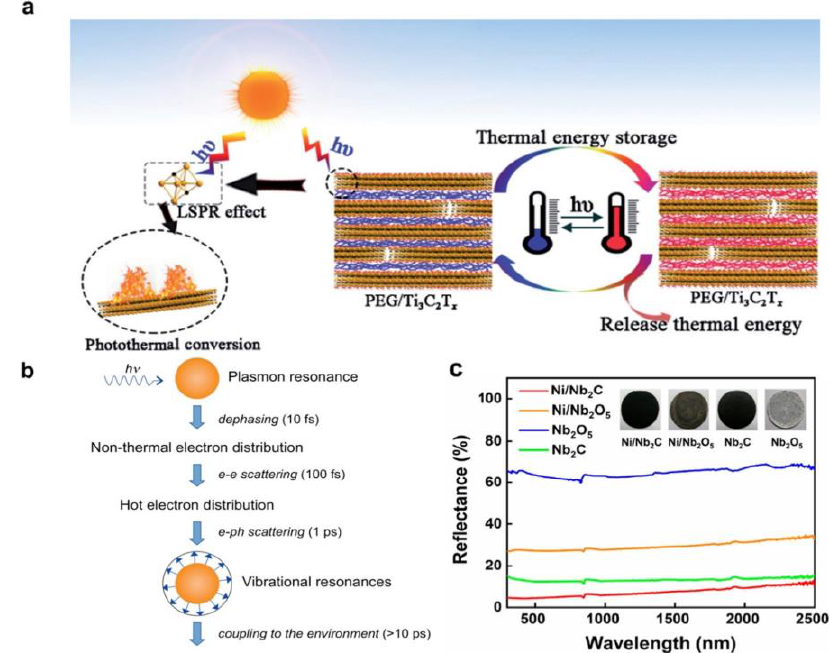
Figure 3. Absorption and photothermal conversion properties of MXenes. ( a ) Schematic illustration of the mechanism of photothermal energy conversion and storage of MXene − based materials. (Reprinted with permission from Ref. [50]. 2019 Royal Society of Chemistry); ( b ) Sequence of events and approximate time scales following absorption of photons. (Reprinted with permission from Ref. [72]. Copyright 2011 American Chemical Society); ( c ) Diffuse reflectance spectra of MXene − based photothermal catalysts. (Reprinted with permission from Ref. [73]. Copyright 2021 American Chem-